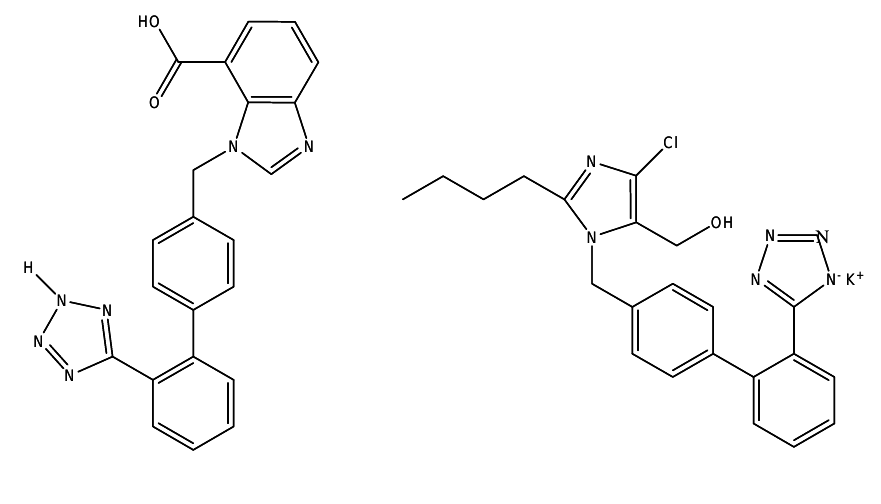
Figure 6. Chemical structures of ARB: candesartan (left) and losartan potassium (right). (BPT: biphenyltetrazole)